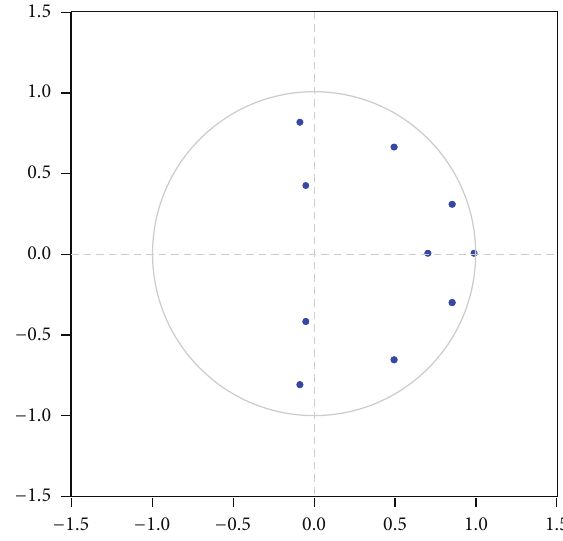
Figure 1: Inverse roots of AR characteristic